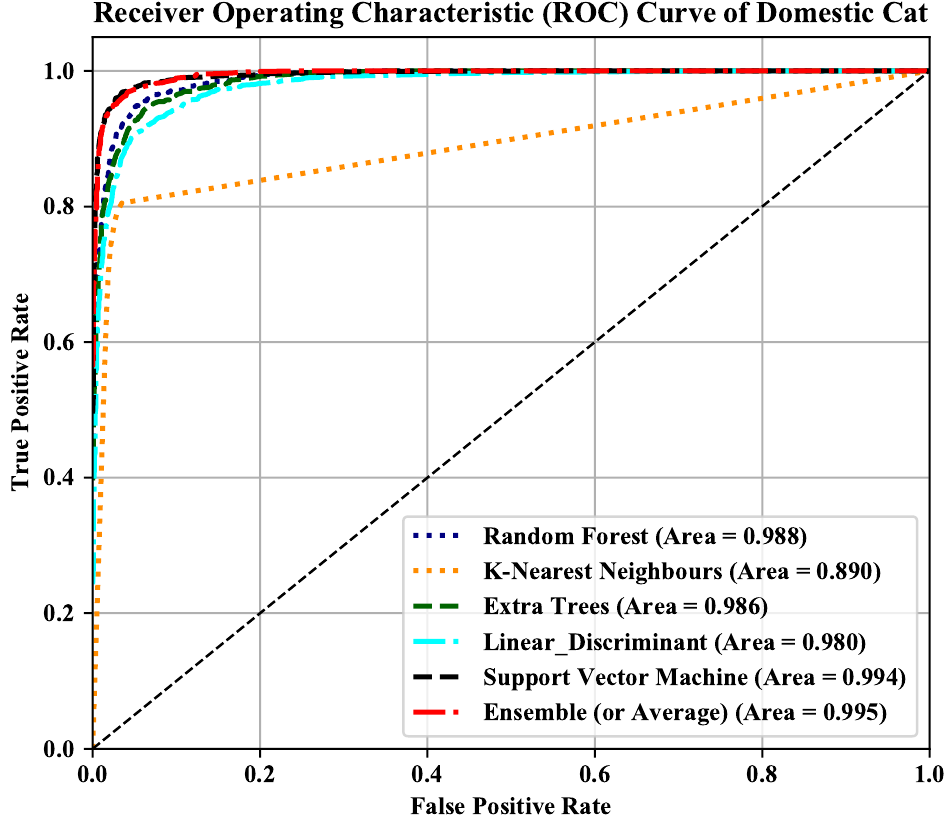
Figure 8. ROC curves of the various classifiers with 3x_Aug datasets using CDBN features. Each curve is represented by a unique color and corresponding AUC score is given in